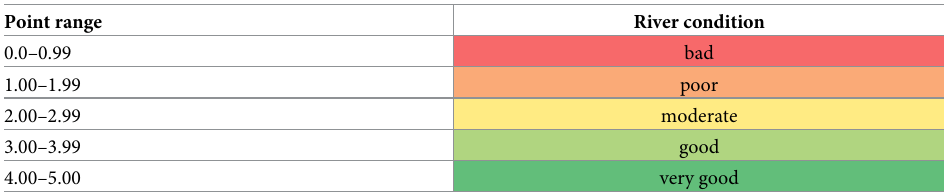
Table 7. CALR river rating